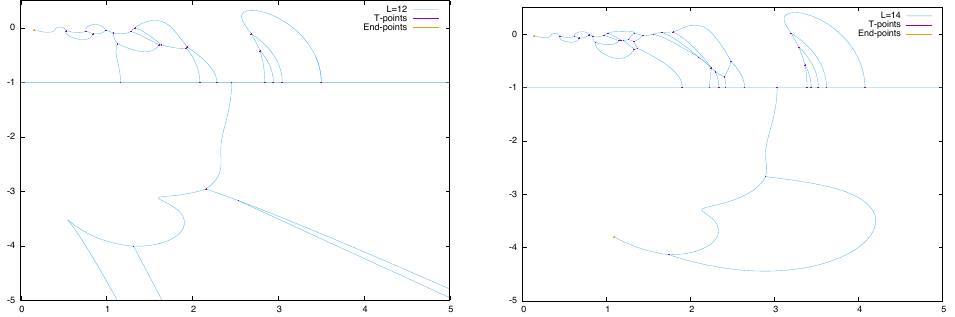
Figure 10 . Condensation curves for partition function zeros on a (2 M + 1) (cid:2) 2 N cylinder, in the limit M ! 1 (closed channel), for a system exhibiting spin-zero and dihedral symmetry D N . The panels show the cases N = 6 ;